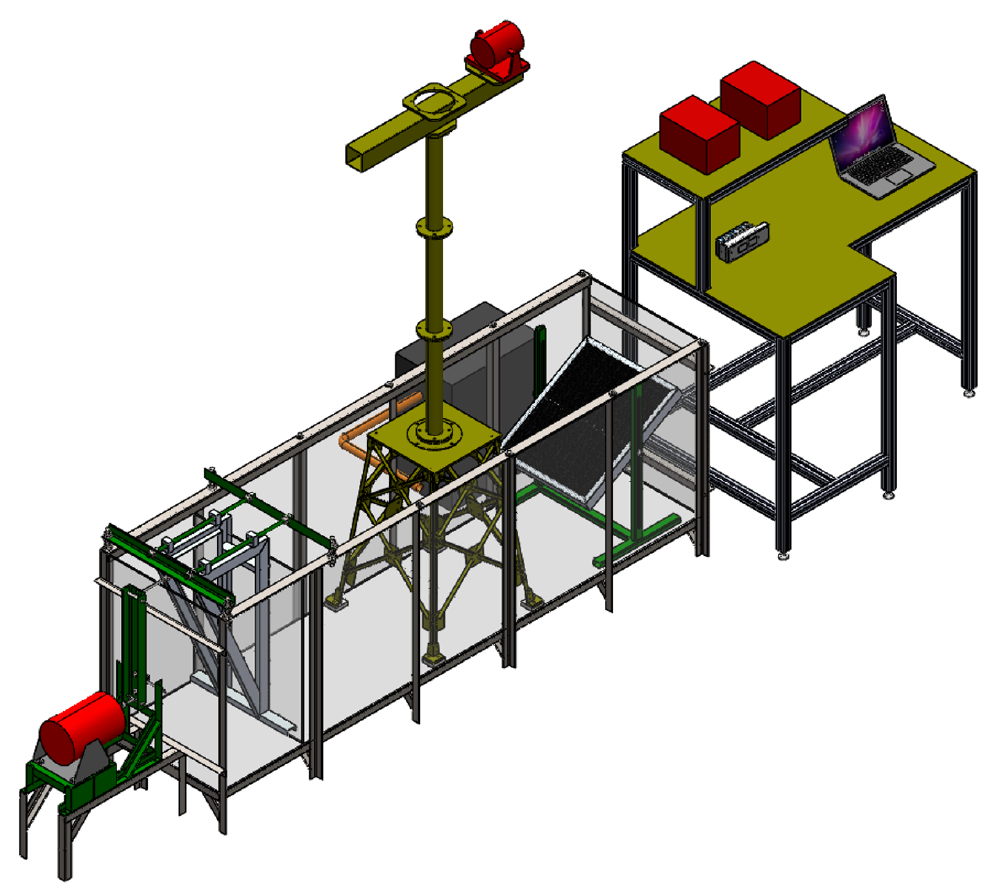
Figure 9. Complete assembly for the wave generator channel